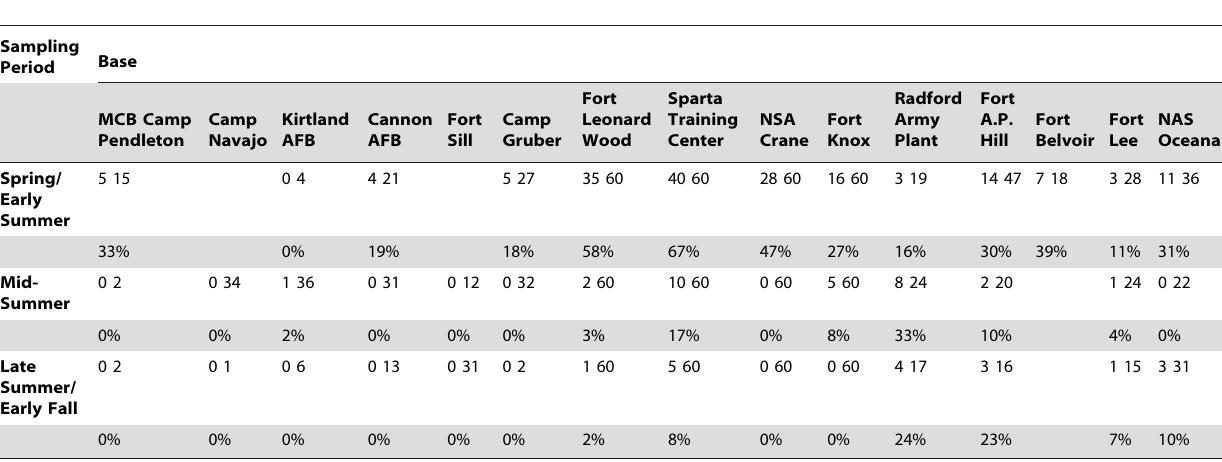
Table 1. Summary of percent Bd -positive amphibians detected at each DoD installation for each of the three 2009 sampling periods.